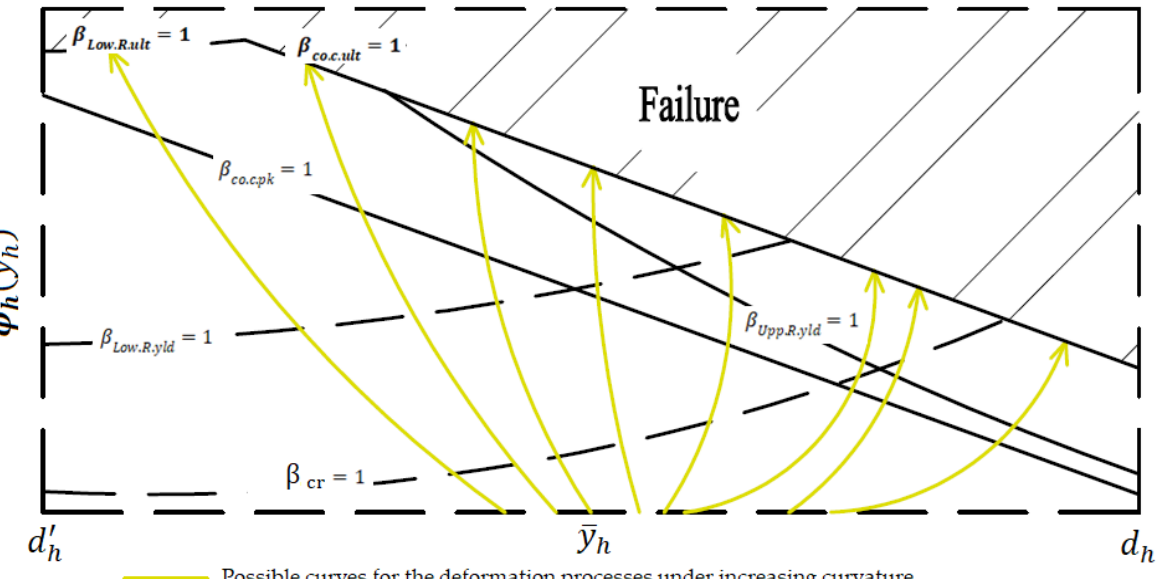
Figure 15. The possible deformation processes under increasing curvature.